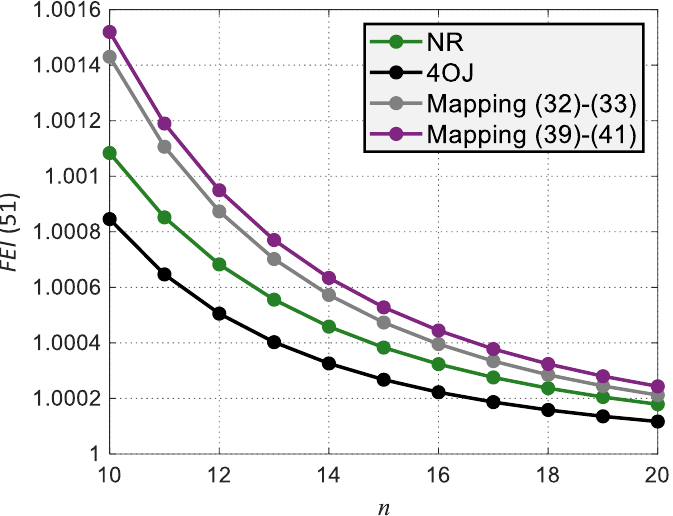
Figure 1. Value of the efficiency index (51) for NR, 4OJ, and the developed methods (32)-(33) and